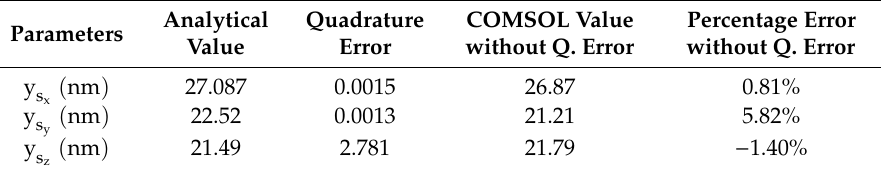
Table 6. Quadrature error estimation in sense-displacement.